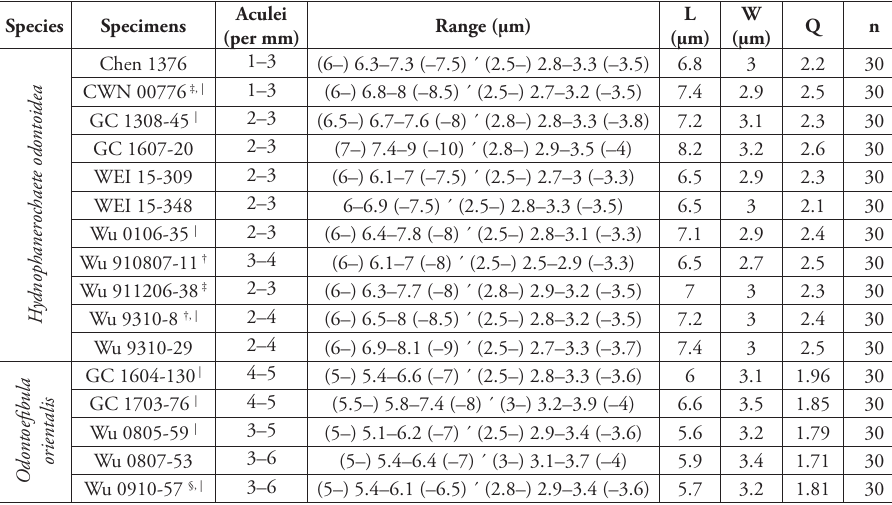
Table 2. Aculei and basidiospore measurements of basidiocarps. Species